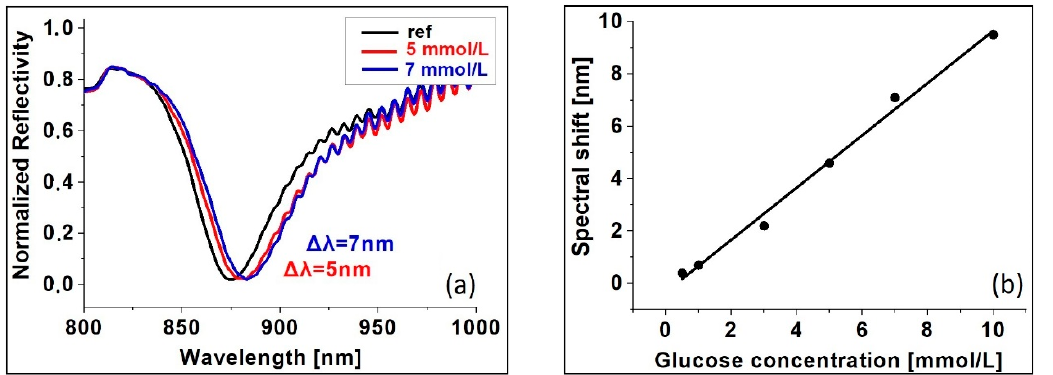
Figure 7. SPR registration of Hb-glucose binding; ( a ) SPR at different glucose concentrations; ( b ) SPR shift vs glucose concentration.